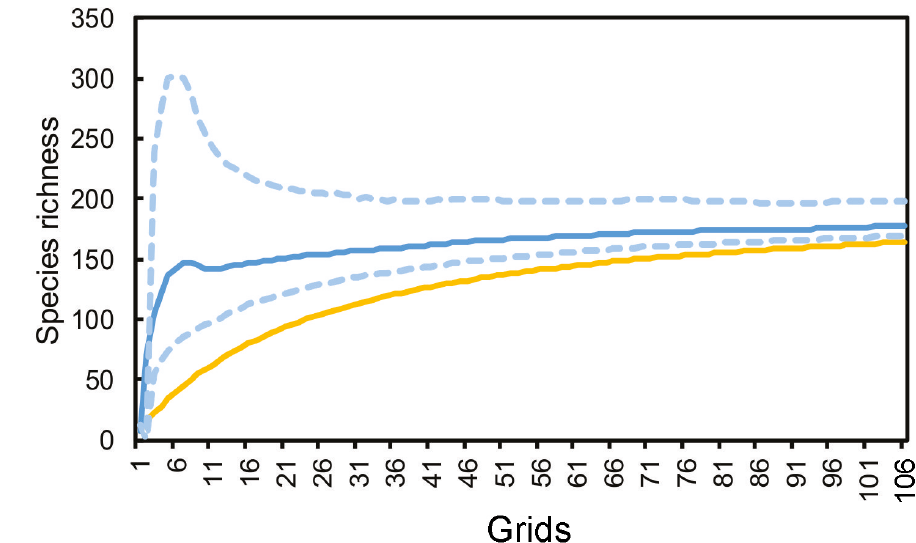
Figure 5. Species richness of marine benthic caridean shrimps in Eastern Tropical Pacific. Orange continuous line = observed richness, blue continuous line = expected richness, blue long-cut lines = confidence interval (95%). Expected species number and confidence intervals (95%) were generated after 10,000 randomizations with replacement using non-parametric Chao2